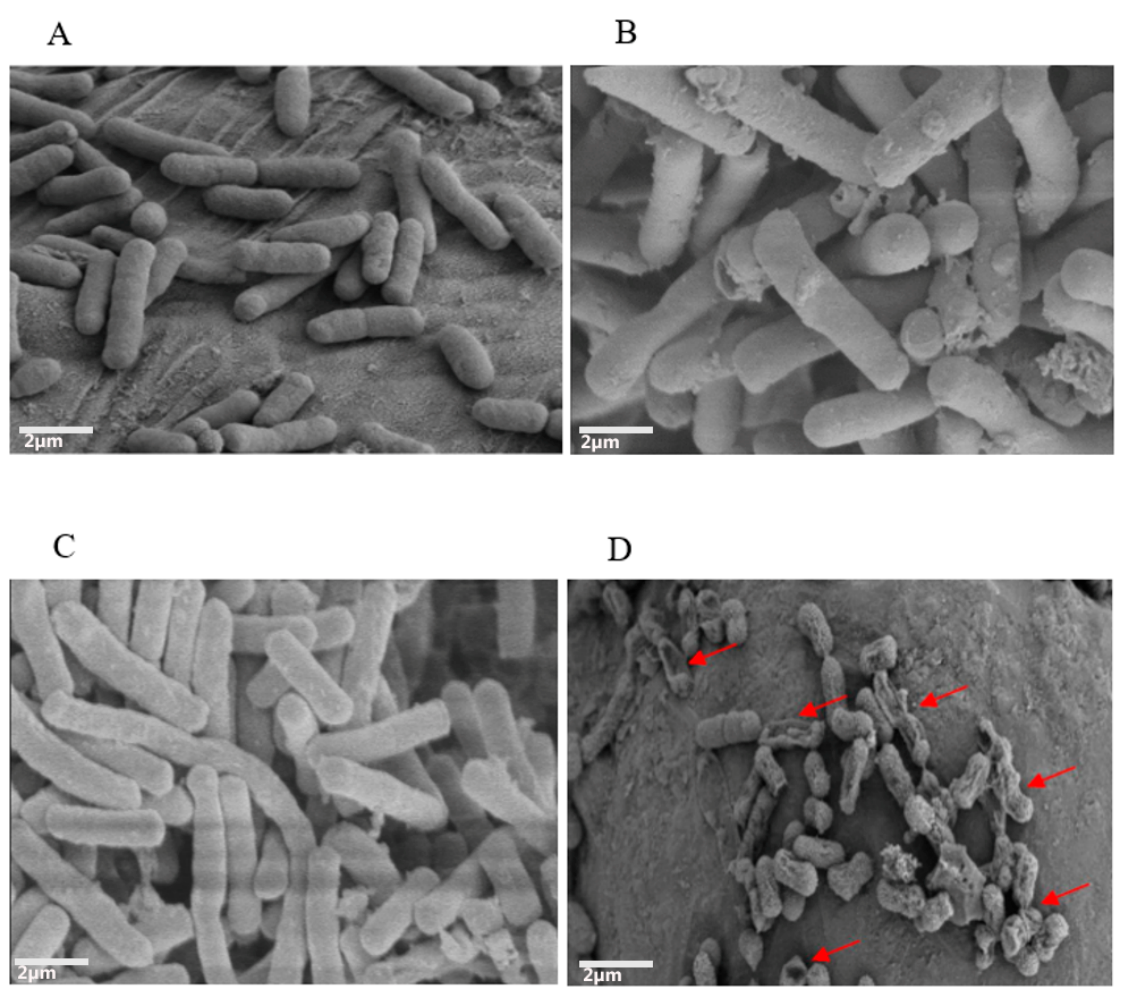
Figure 2. Colistin and tetrandrine, in combination, kill colistin-resistant E. coli . Fluorescence micro- scopic observation of ( A ) control: cells growing in the absence of colistin and tetrandrine. ( B ) Colistin alone does not inhibit the growth of E. coli , ( C ) tetrandrine alone does not inhibit the growth of E. coli , and ( D ) cells treated with colistin plus tetrandrine in combination show numerous dead cells.